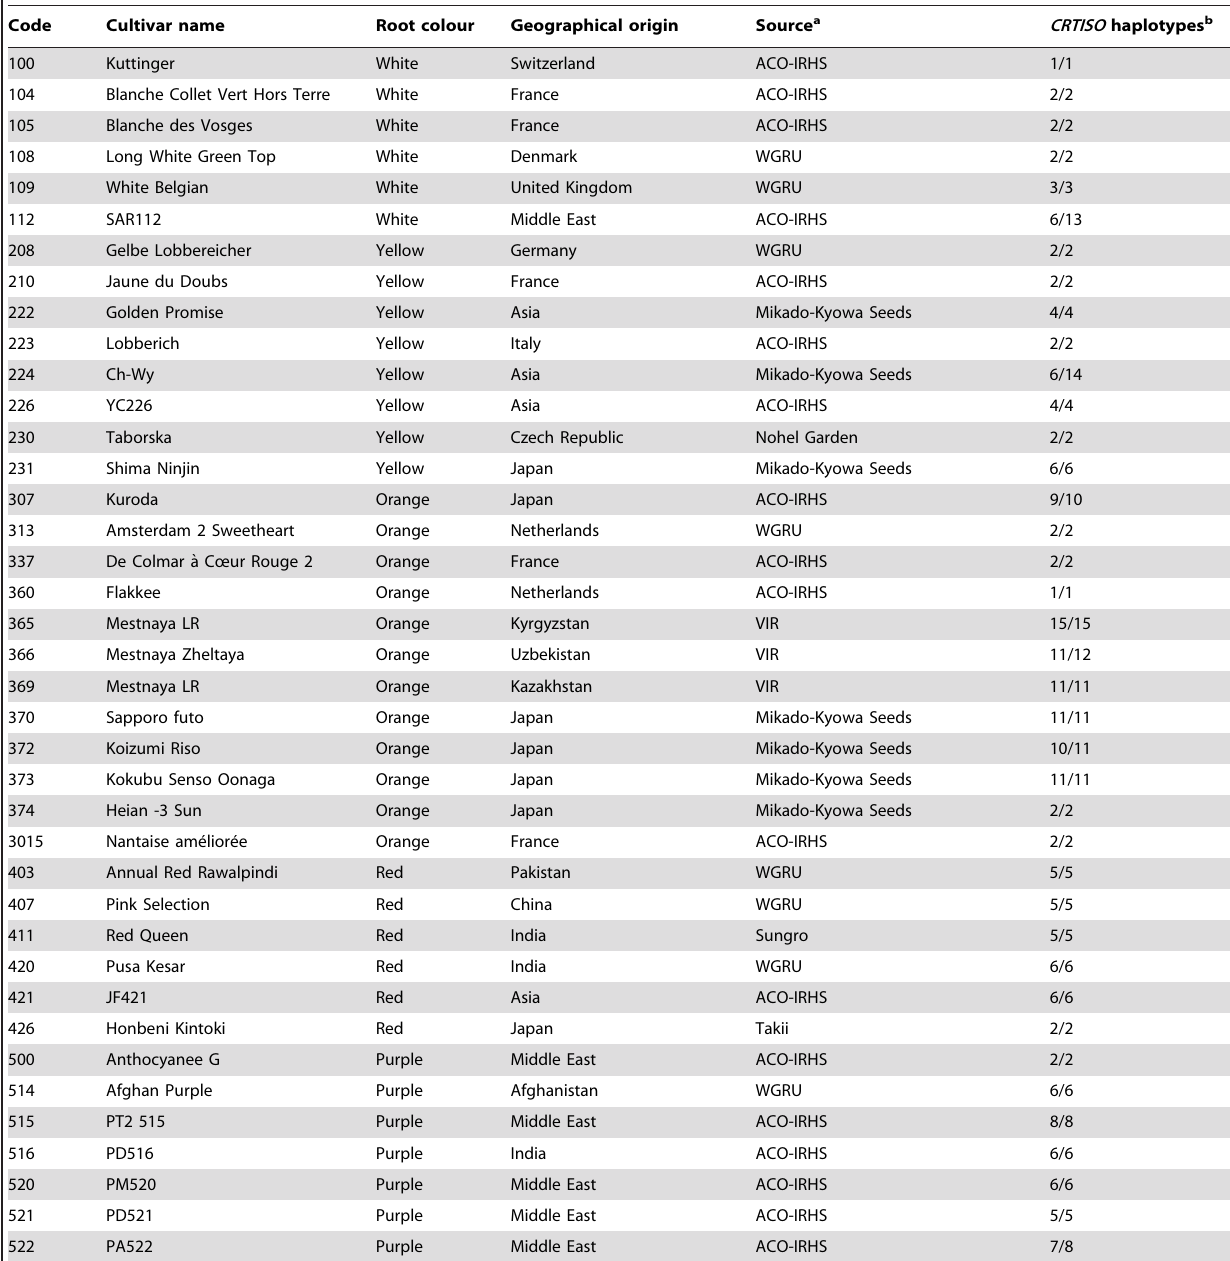
Table 1. List of carrot cultivar